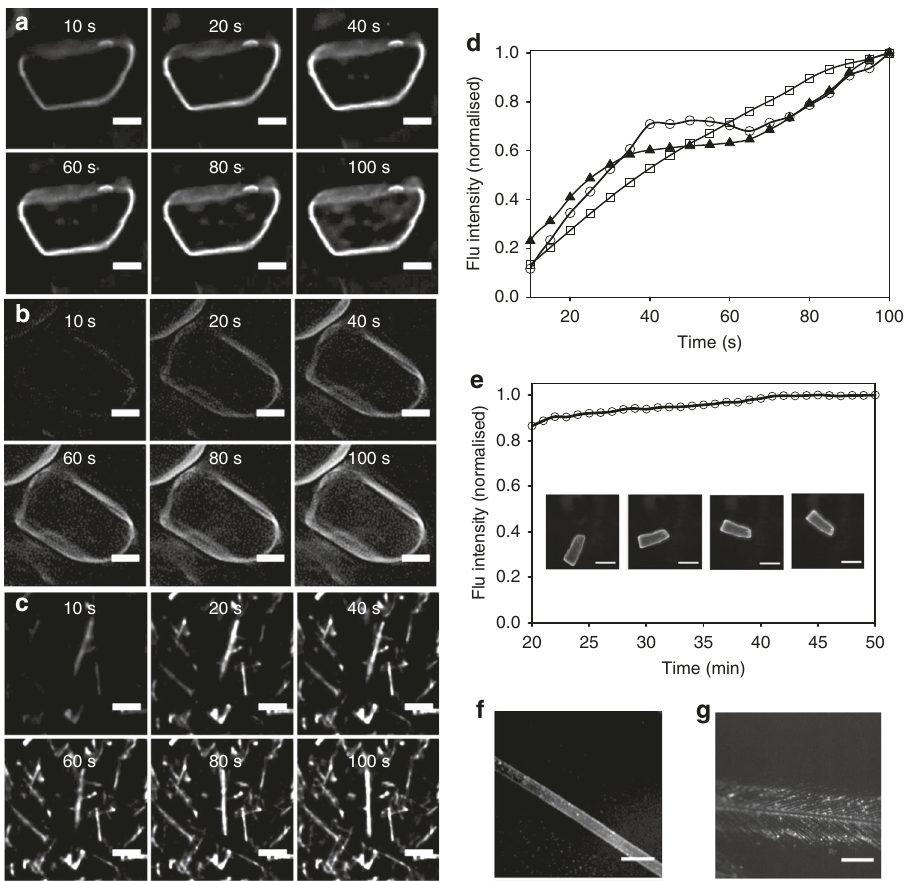
Fig. 6 Real-time fl uorescence imaging of adsorption at drug crystal surfaces over 120 s following treatment with aqueous NP 1- P 188 ( fl uorescence shown in white for clarity) and NP 1- P 188 labelling of natural fi bre surfaces. a Naproxen (Supplementary Movie 1). b Ibuprofen (Supplementary Movie 2). c Paclitaxel (Supplementary Movie 3). Scale bars = 10 μ m. See Supplementary Fig. 7 for alternative views showing images as red fl uorescence overlaid on the differential interference contrast (DIC) images and Supplementary Movies 4 – 6. d Plot of increasing drug crystal surface fl uorescence over time for the fi elds of view shown; naproxin (circles), ibuprofen (squares), paclitaxel (triangles). e Plot of fl uorescence stability of adsorbed 1 /P surface in water over 50 min. Individual crystal shown at 20, 30, 40, 50 min (Supplementary Movie 13). f Fluorescence image following treatment of human hair with NP 1 -P 188, scale bar = 250 μ m. g Fluorescence images following treatment of feather with NP 1 -P 188 , scale bar = 250 μ m. P 188 negative controls (Supplementary Fig.